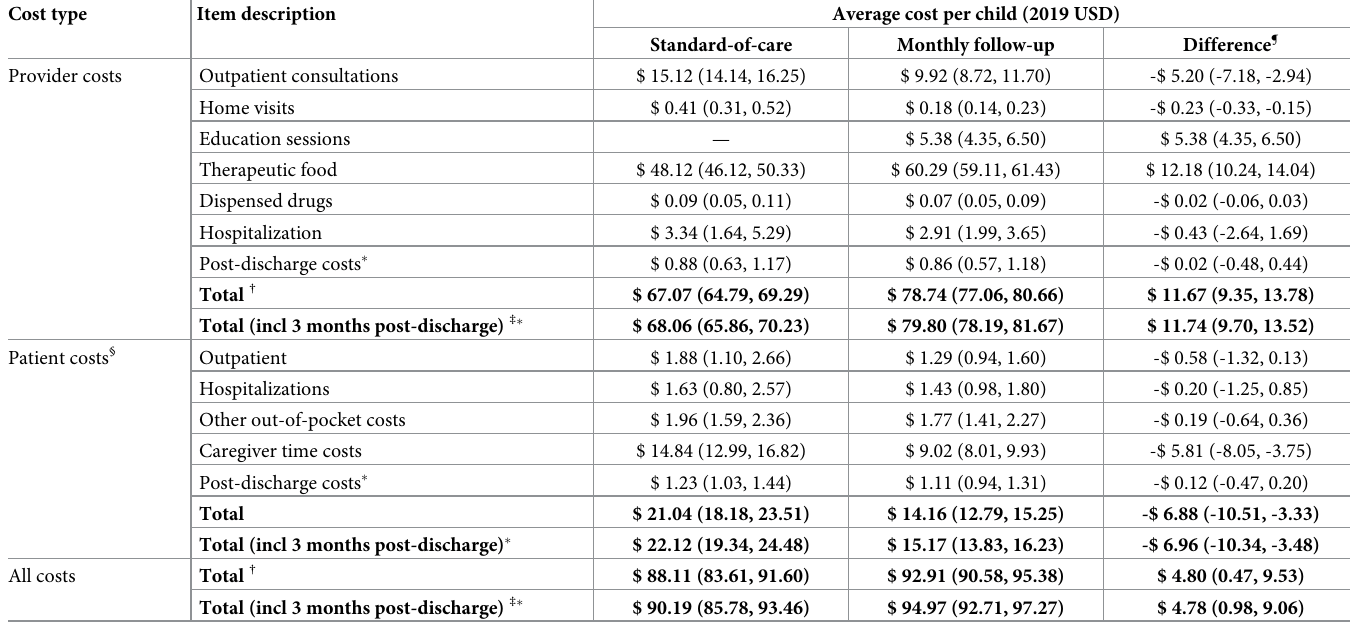
Table 2. Per child costs by intervention arm and cost